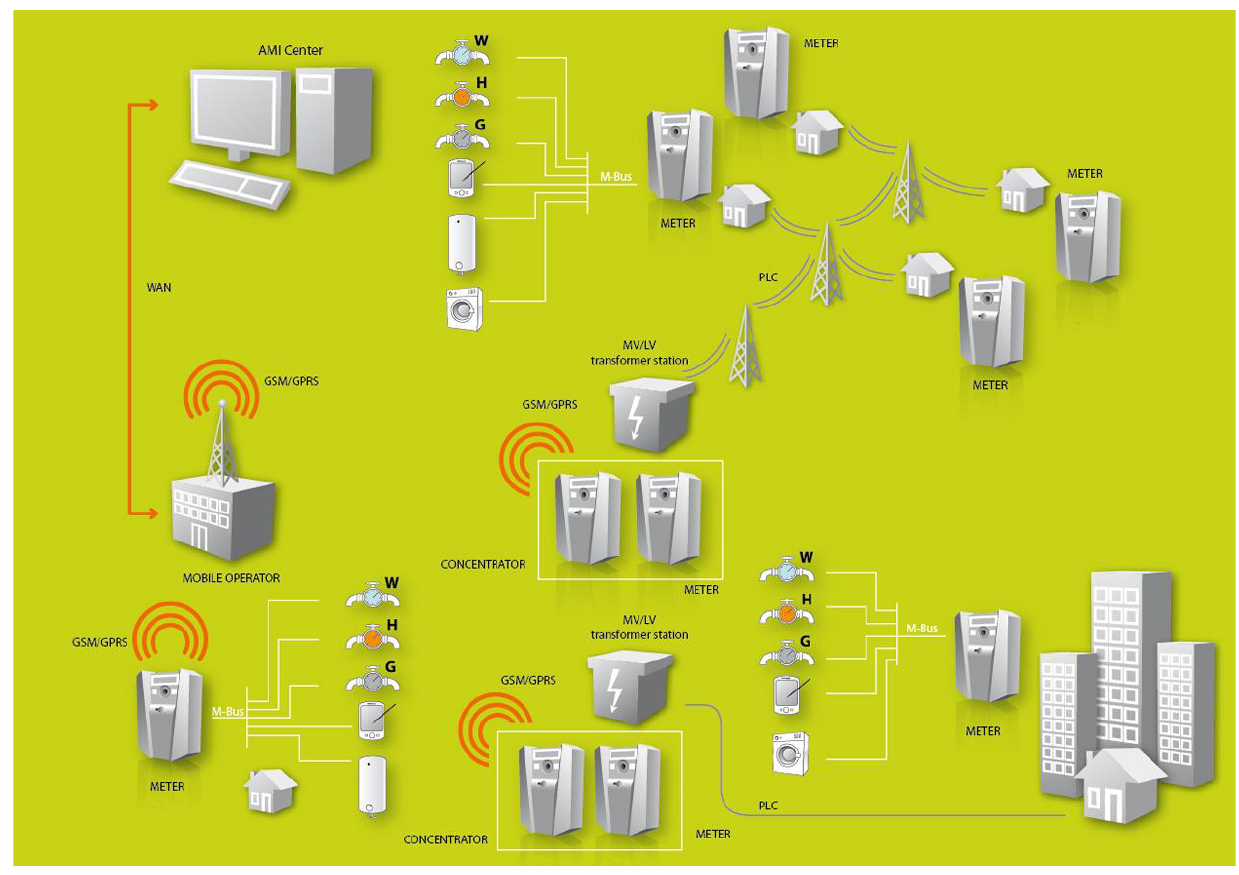
Figure 4. The subsystem for remote control of smart